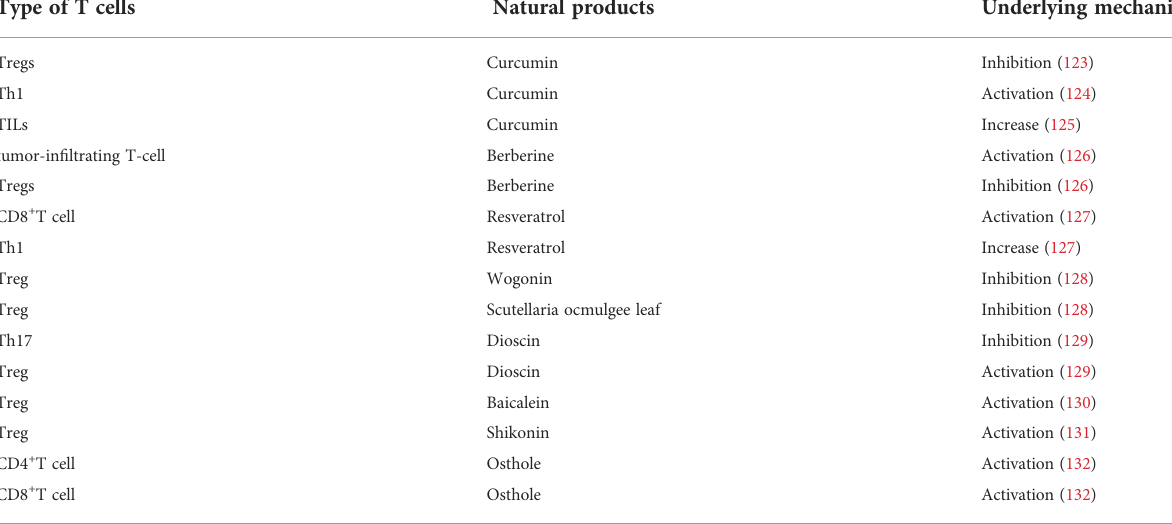
TABLE 2 Natural products participate in the regulation of T